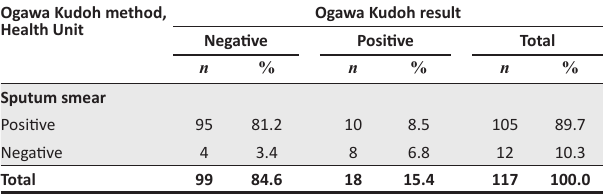
TABLE 2: Results ratio of mycobacterial culture and direct microscopy, Mozambique, 2014. †